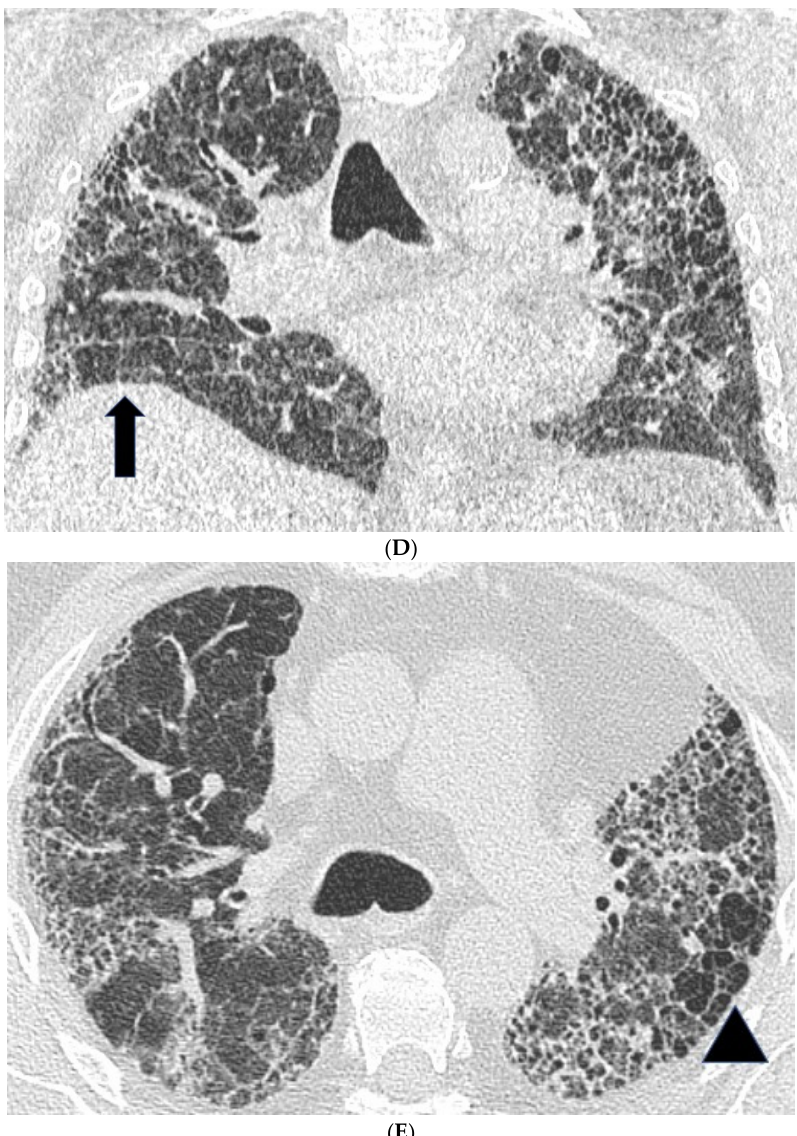
Figure 1. Features suggestive of chronic hypersensitivity pneumonitis in different patients. ( A ) Spared pulmonary lobules are visible within non ‐ fibrotic lung bilaterally (arrows); background fibrosis is evidenced by peripheral reticulation and traction bronchiectasis (black arrowheads). ( B , C ) A predilection towards bronchocentricity of the fibrosis in the upper lobes is evident on axial (arrowheads) and coronal (arrows) images. ( D ) An upper and midzone predominance to the fibrosis, characterised by reticulation and traction bronchiectasis, is seen on a coronal CT. Incidentally, volume loss in the right lung is noticeable by slight tenting and elevation of the right hemidiaphragm (arrow). ( E ) A UIP pattern with honeycomb cysts is visible in the left midzone of the lung (arrowhead) in a 74 ‐ year ‐ old male ex ‐ smoker. A surgical biopsy performed a few years before this CT had demonstrated findings compatible with fibrotic hypersensitivity pneumonitis. In a study of 92 patients with fibrotic HP, ground glass opacification and reticulation were the most prevalent patterns of interstitial disease [27]. Interestingly, microcystic and macrocystic honeycombing were described in 32% and 13% patients, respectively. The prevalence of traction